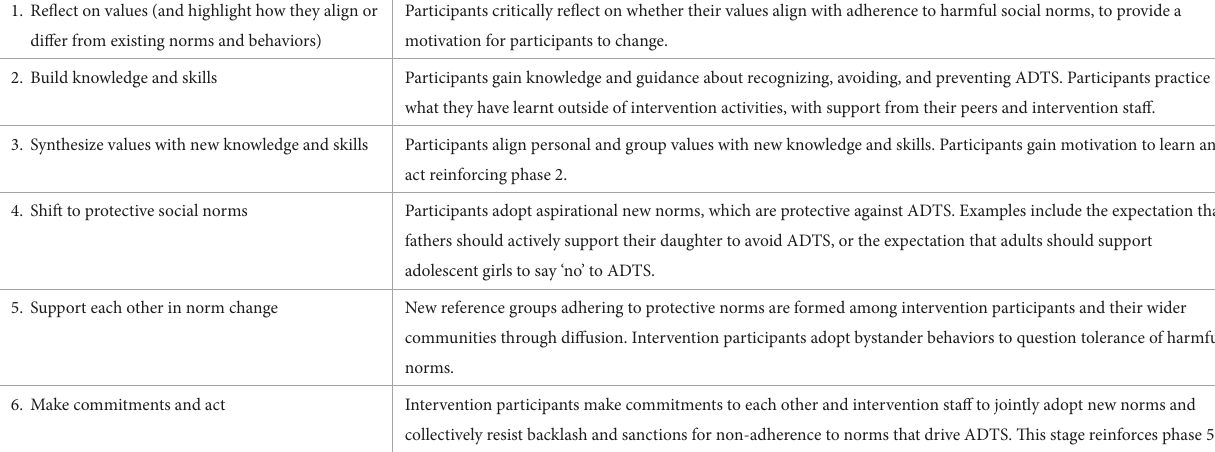
TABLE 3 Learning Initiative on Norms, Exploitation, and Abuse (LINEA) Intervention theory of